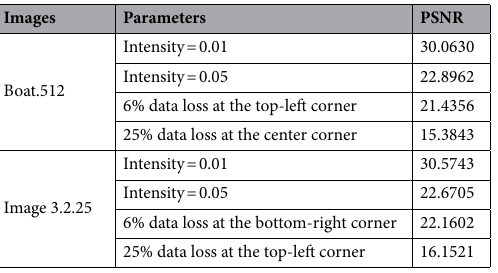
Table 6. Quantitative results of resisting noise and occlusion